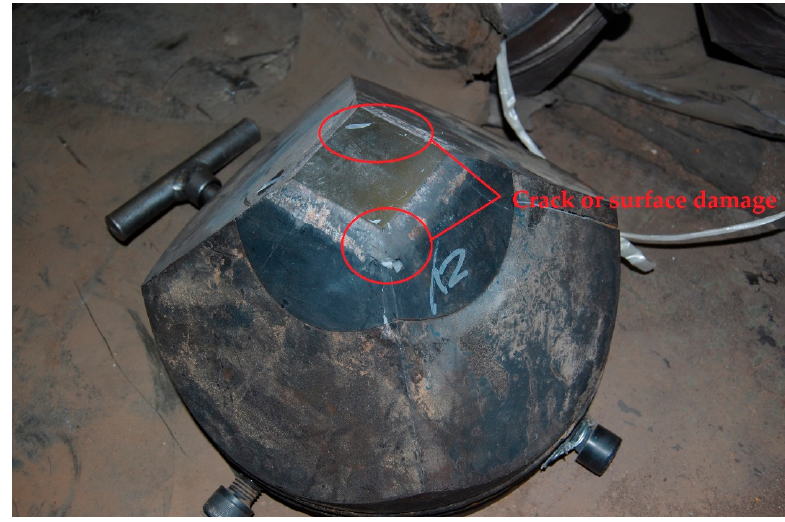
Figure 6. The cracked anvil.